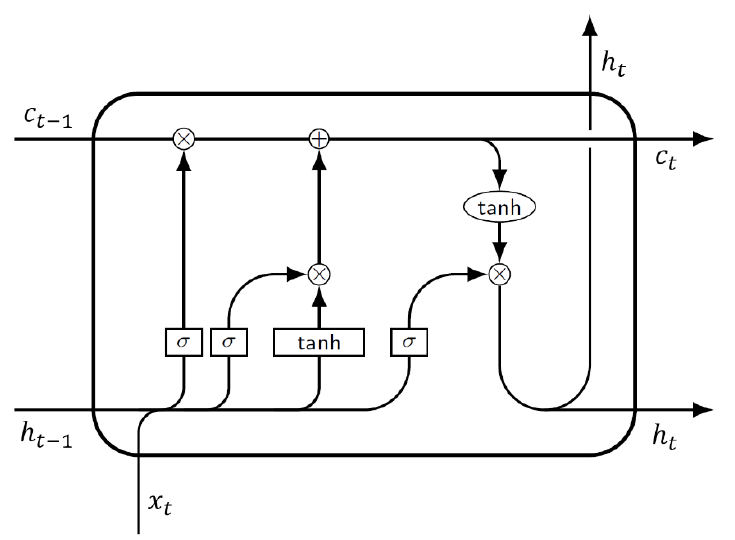
Figure 8. A representation of an LSTM cell. From left to right, the σ -blocks are called the forget, input, and output gates. The forget gate controls the amount of information allowed to flow in from the past, while the input and output gates look at the current input and previous hidden state to determine the outputs of the cell. In the diagram above, the σ refers to a sigmoid activation function.